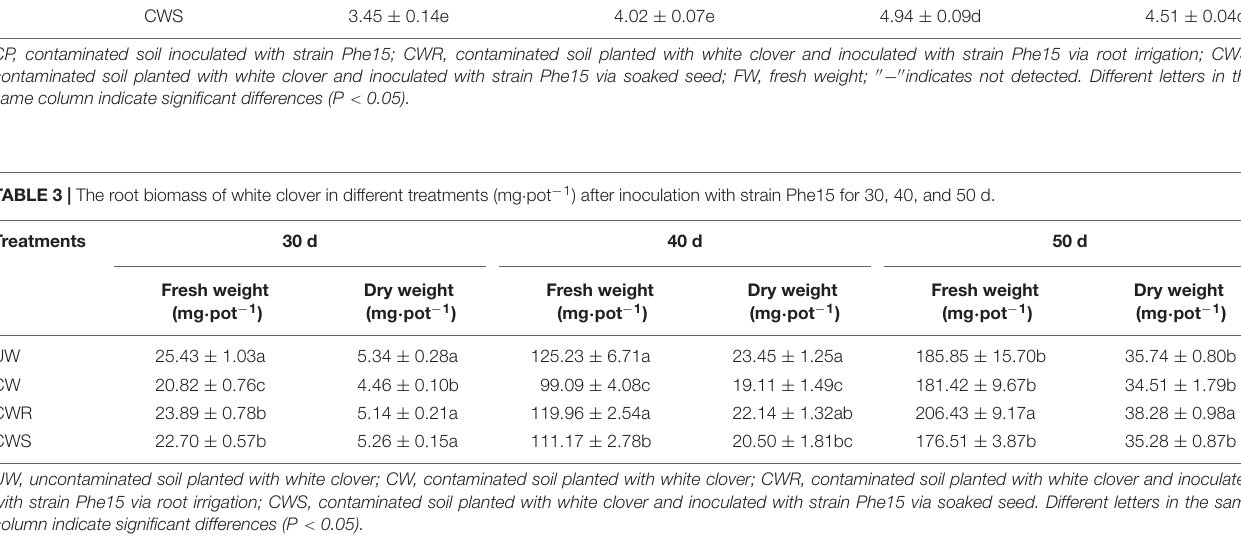
TABLE 4 | The shoot biomass of white clover in different treatments (mg · pot − 1 ) after inoculation with strain Phe15 for 30, 40, and 50 d. Treatments